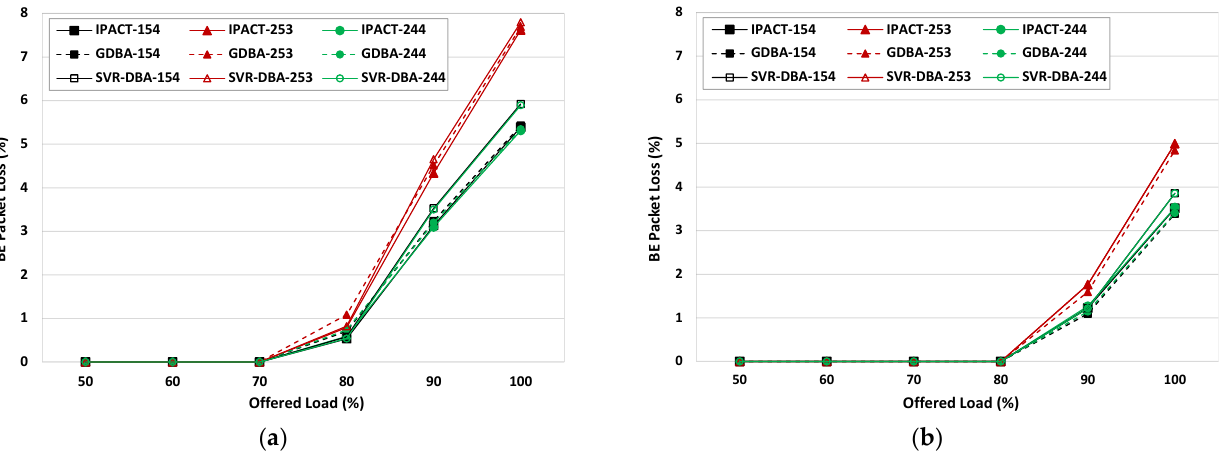
Figure 7. BE packet loss for different scenarios: ( a ) BE packet loss for 1.0 ms cycle time; ( b ) BE packet loss for 1.5 ms cycle time.